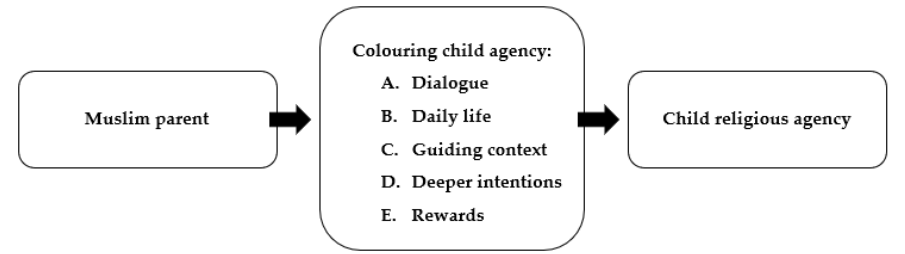
Figure 1. A Muslim parent ‘colouring’ a child’s religious agency.